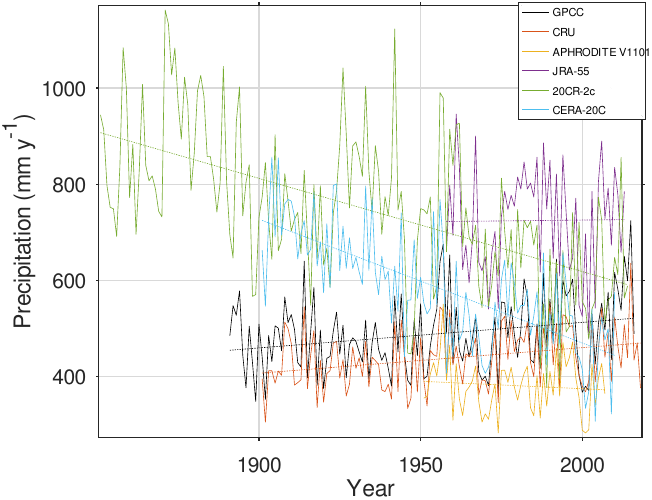
Figure 2. Annual precipitation over the Indus basin according to different gridded data sets, along with the respective linear trendlines (dashed). The data sets that covered at least 50 years are